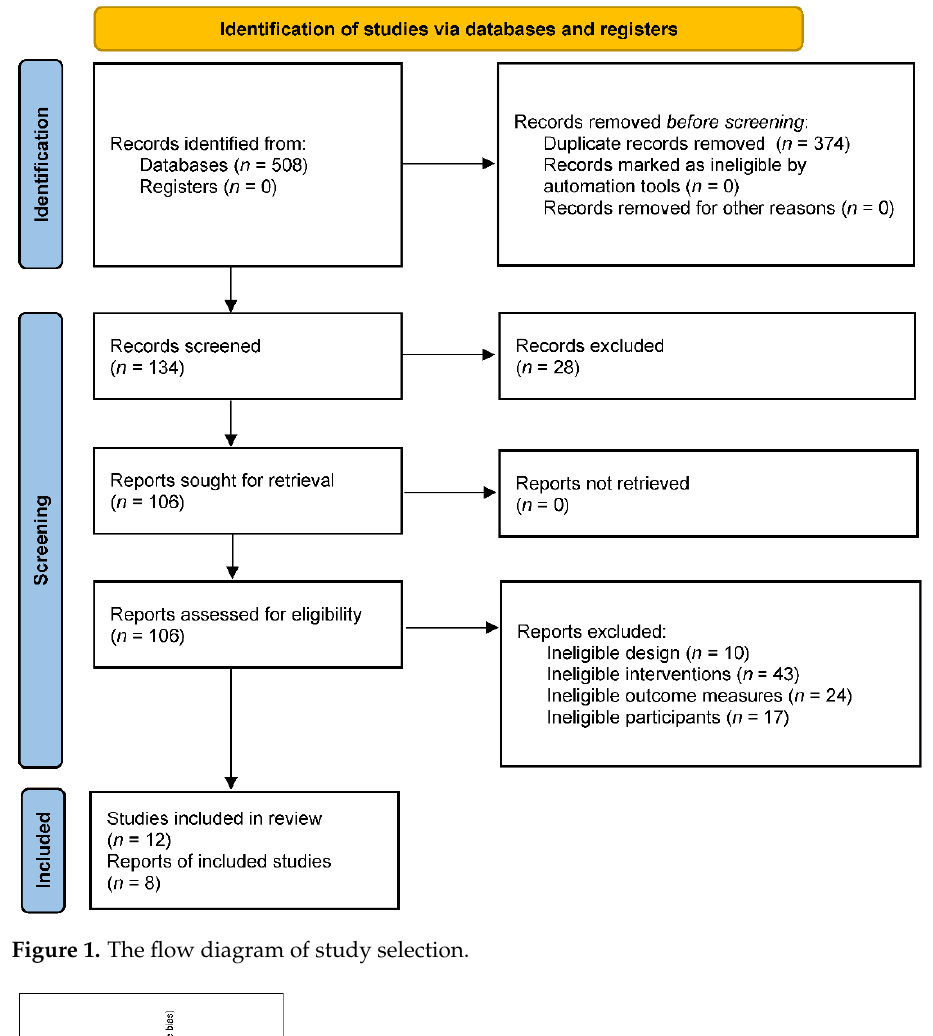
Figure 1. The flow diagram of study selection.